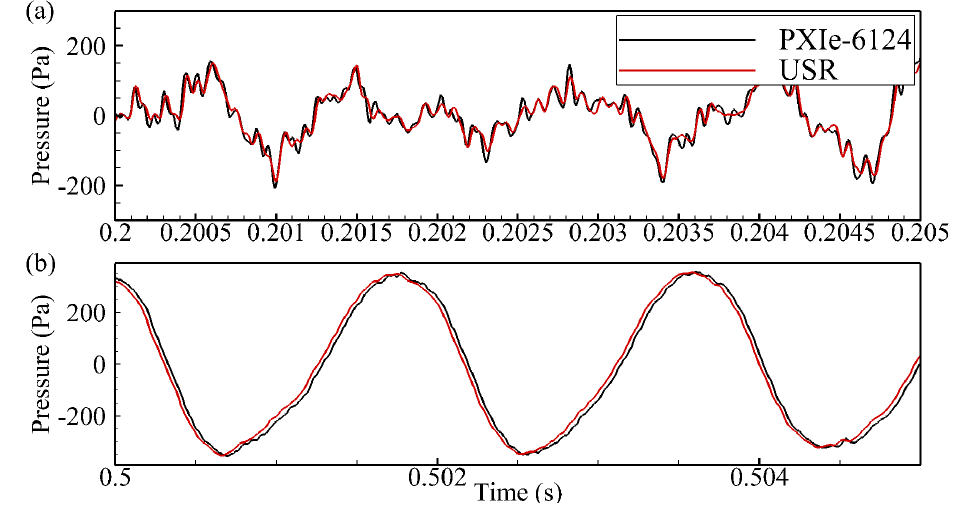
Figure 11. Sample zoomed-in comparisons from the tank testing. ( a ) Underwater explosion; ( b ) whale